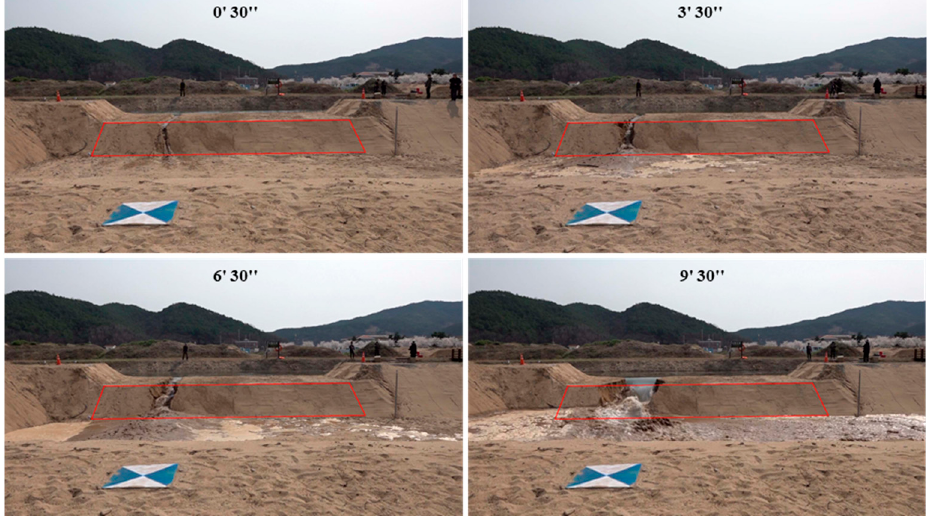
Figure 8. Levee collapse pattern over time immediately after overtopping (Case 1).